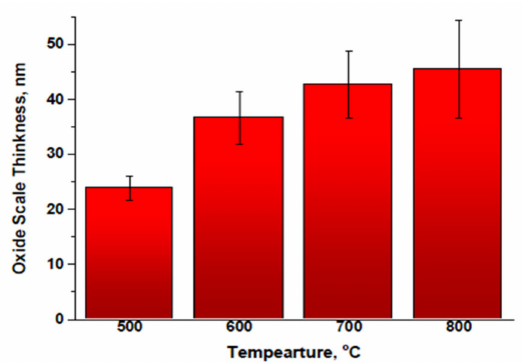
Figure 3. Oxide scale thicknesses as determined from cross-sectional SEM